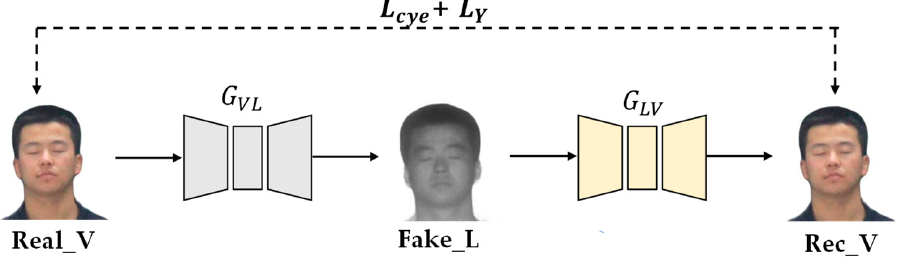
Figure 7. L Y loss function. L loss function. Figure 7. Y